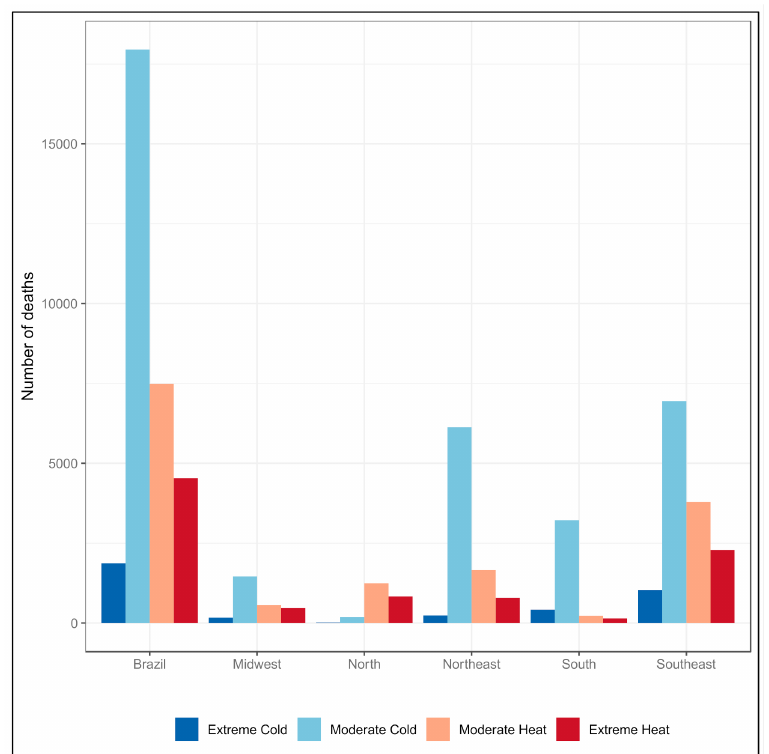
Figure 5. Number of deaths attributable to moderate and extreme temperatures according to region. Brazil, 2000 to